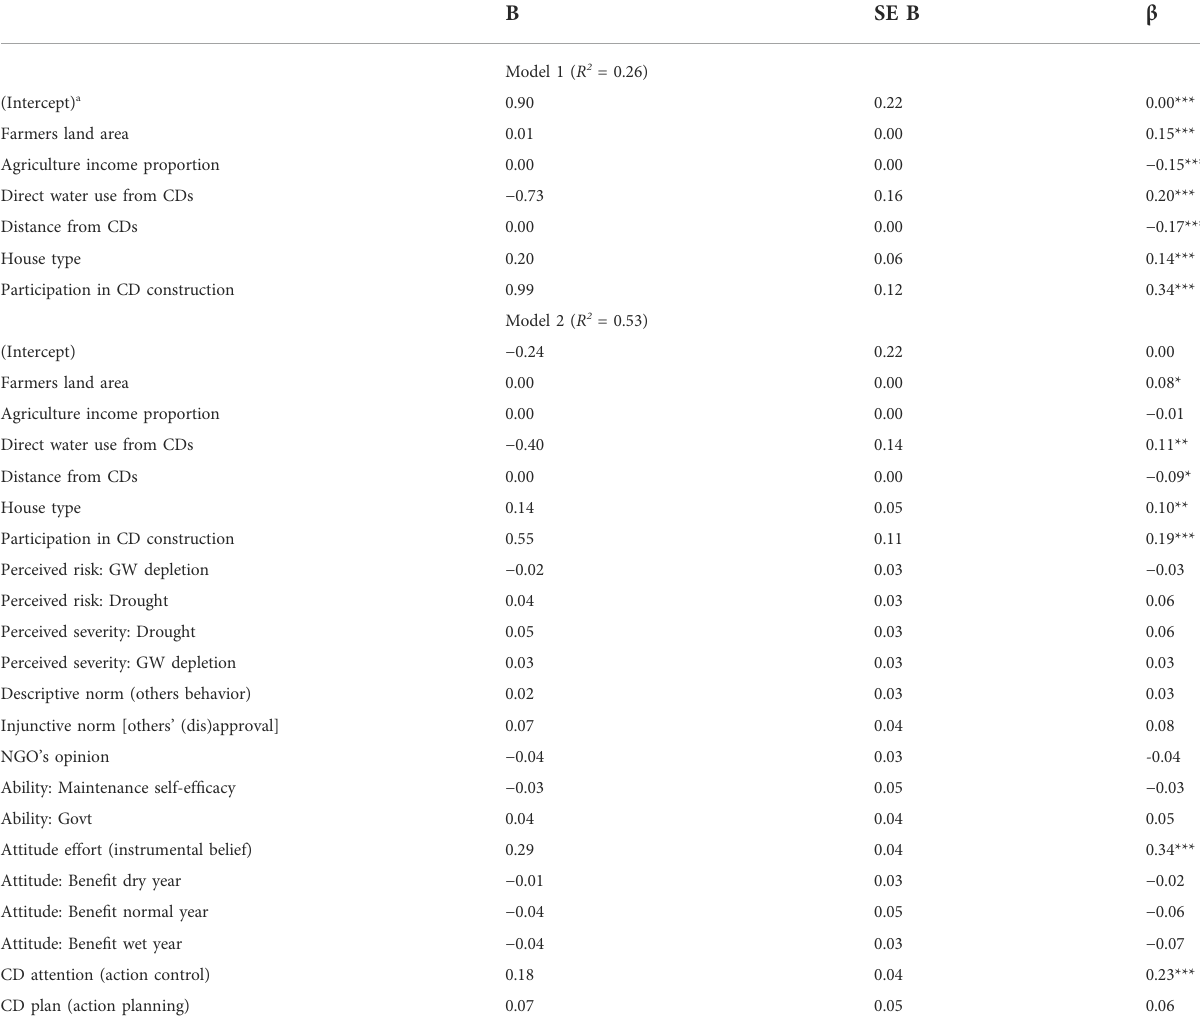
TABLE 4 Results of Hierarchical Regression with Contextual (model 1) and Sociopsychological factors (model 2) for farmers behaviour towards CD